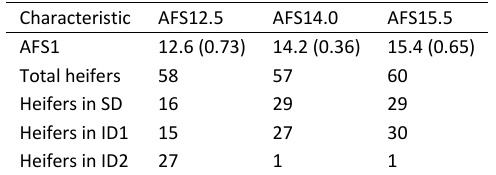
Table 2. Description of the classes of age (in mo) at first service (AFS)